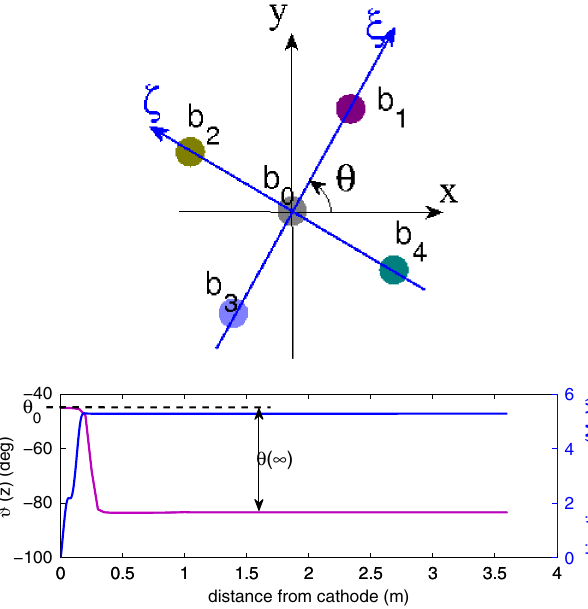
FIG. 7. (Color) Definition of the Larmor ð (cid:10); (cid:11) Þ and laboratory ð x; y Þ transverse coordinate systems (top schematics). Evolution þ (cid:9) ð z Þ between the ð x; y Þ and of the rotation angle # ð z Þ (cid:3) (cid:9) 0 Larmor ð (cid:10); (cid:11) Þ frames (magenta trace) and of the beam’s kinetic energy (blue trace) along the accelerator beam line for ^ B ¼ ¼ (cid:1) 45 (cid:11) and (cid:9) ð1Þ ’ 0 : 376 T (bottom plot). In this example (cid:9) 0 (cid:1) 38 (cid:11) . (cid:1) ð z Þ ¼ R ½ (cid:9) þ (cid:9) ð z Þ(cid:4) X where X (cid:3) ð x; p x ; y; p y Þ . The 0 and (cid:9) ð z Þ are the initial rotation angle of the quantities (cid:9) 0